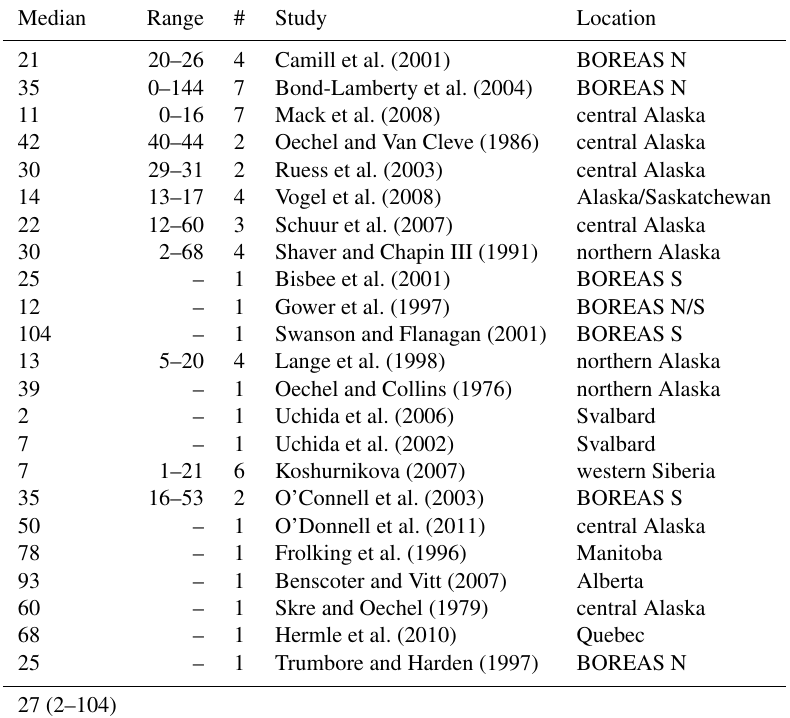
Table B1. Studies which measure NPP in the biomes boreal forest and tundra. Median and range of all values listed in a study are shown, # stands for the number of values. NPP is in gm − 2 a − 1 of carbon. BOREAS N or S stands for the northern and southern site of the BOREAS project (e.g. Gower et al., 1997). BOREAS N is located in Manitoba, Canada and BOREAS S is located in Saskatchewan, Canada. The last row shows median and range of the values in the first column.